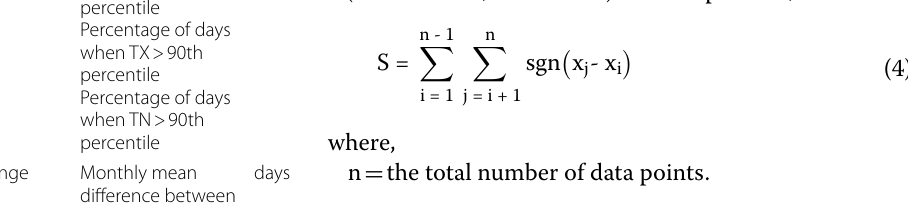
Warm days Warm nights